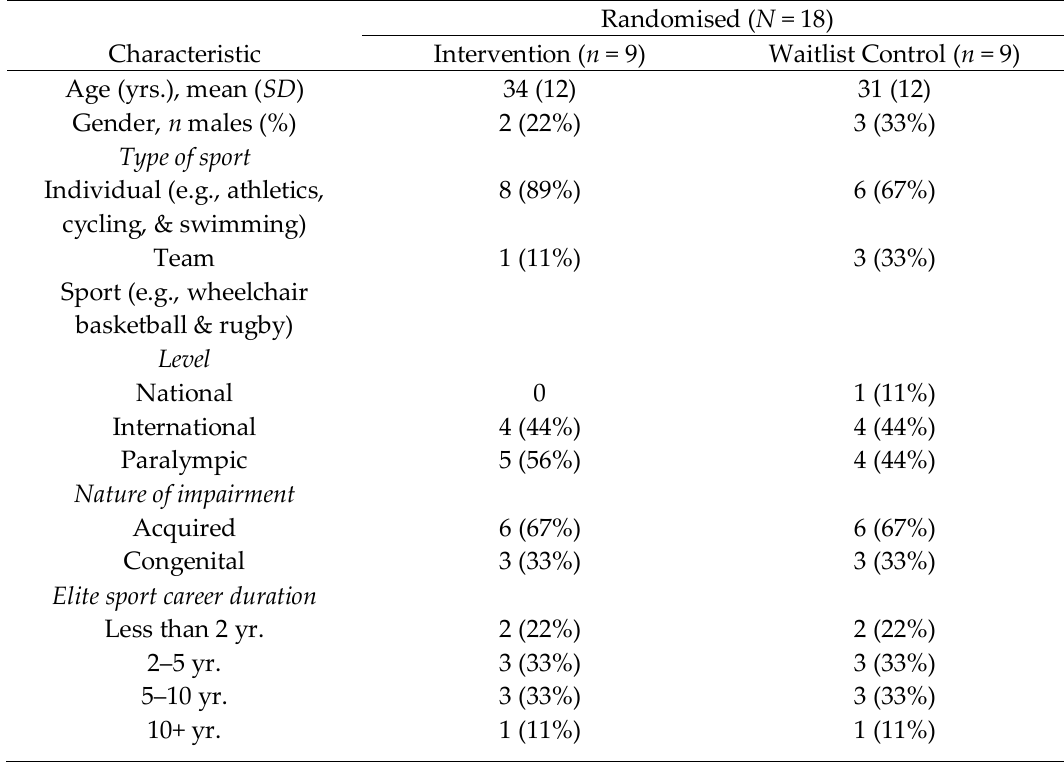
Table 2: Demographics of Participants